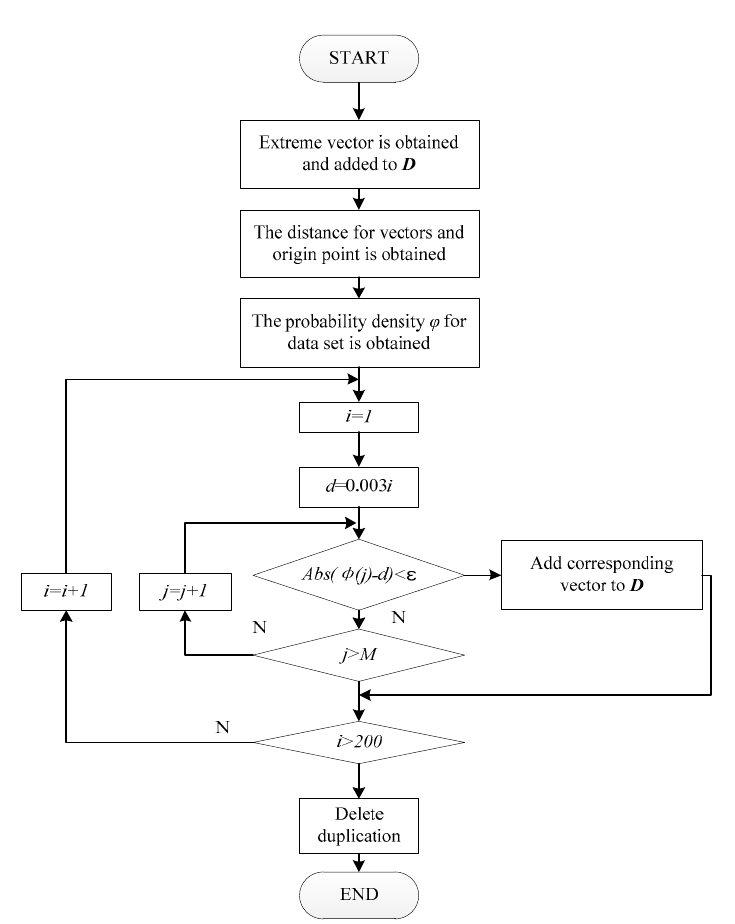
Figure 3. Procedure for constructing memory matrix D.